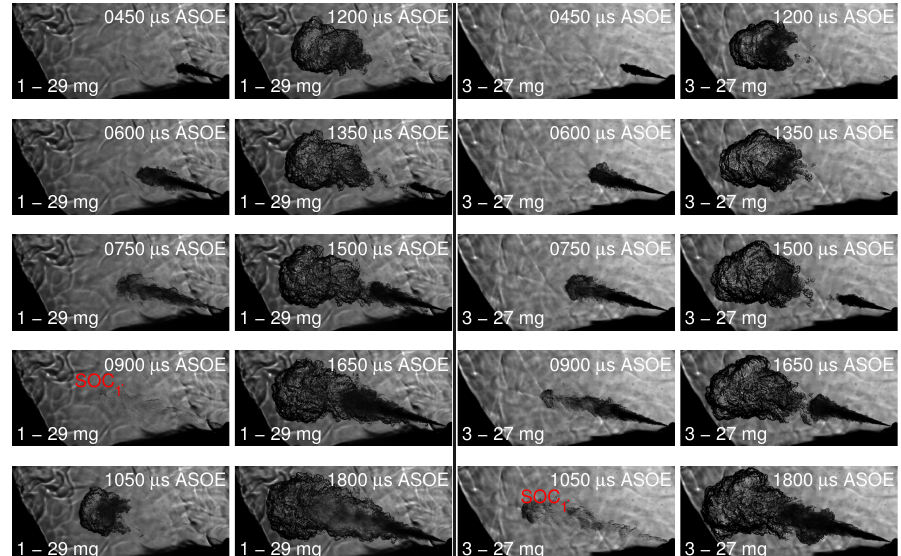
Figure 15. Sequence of schlieren images of a pilot injection of 1 mg and other of 3 mg. The images show the ignition of the first pulse for each mass quantity before the second pulse. The frames are referenced to the start of energizing (SOE). The conditions are 900 K of chamber temperature, a rail pressure of 100 MPa, chamber density of 15.2 kg · m − 3 , and a dwell time of 650 µ